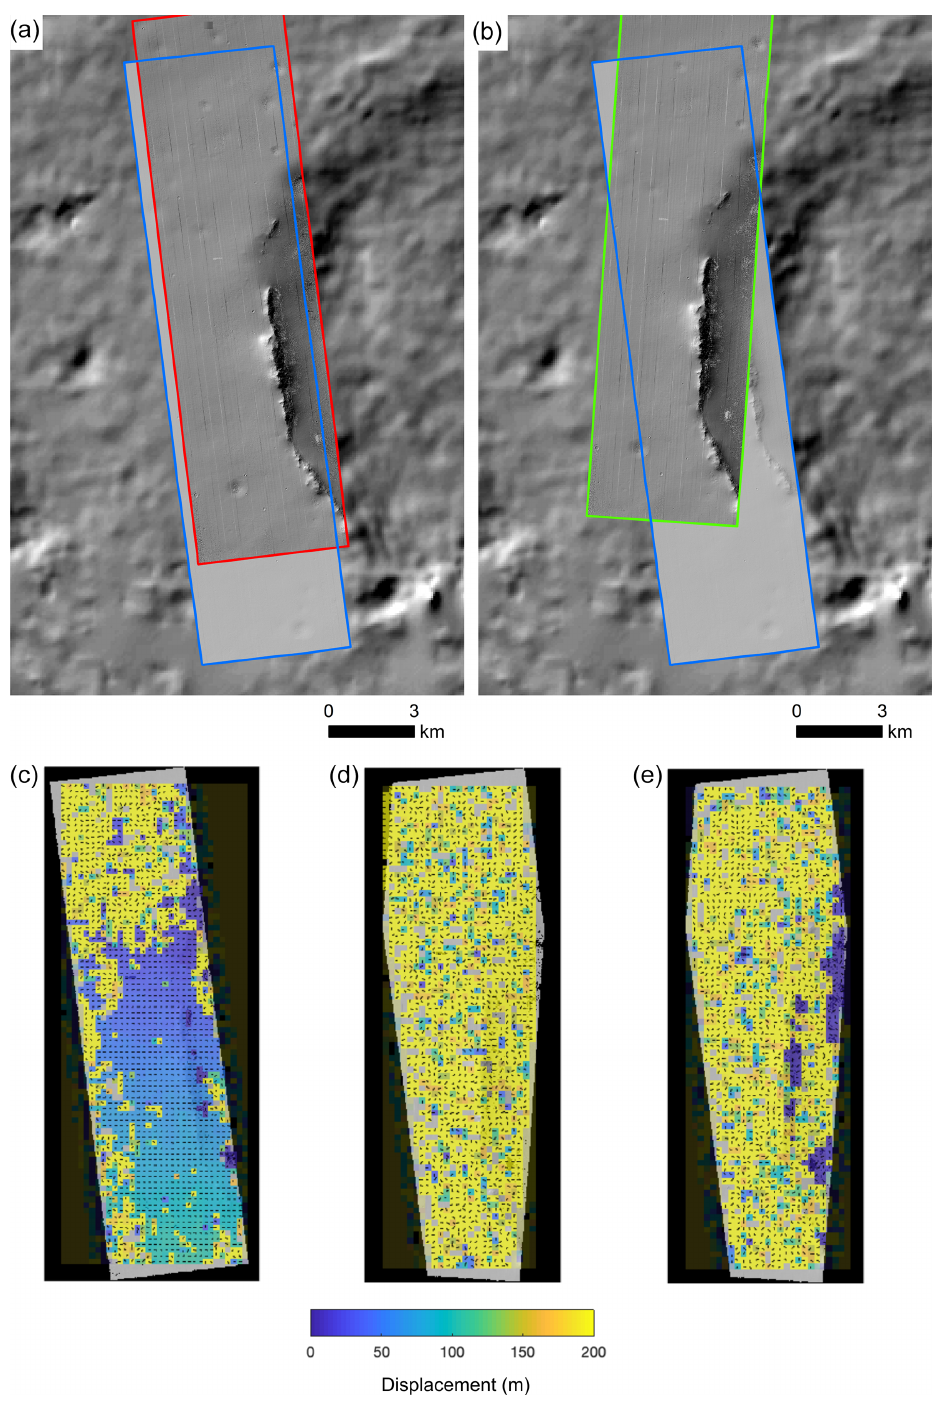
Figure A2. Site 3 DEM alignment between AU DEM 3, the PDS DEM (DTEEC_018701_1775_018846_1775_U01: https://bit.ly/2TrxFXX, last access: 9 February 2019), and the HRSC DEM (h3198_0001). (a–b) Hillshaded PDS DEM (blue box), the AU DEM 3 pre-pc_align (red box), and AU DEM 3 post-pc_align (green box). Background is the hillshaded HRSC DEM. Note the longitudinal artefacts associated with HiRISE bands. (c) Displacement between the AU ( pre-pc_align ) DEM and the PDS DEM. Low displacement around the crater rim indicates strong agreement. Elsewhere, the low-texture terrain hampers pixel matching. (d) Displacement measured between the two AU DEMs. Overlap is limited to flat-featureless terrain, making pixel matching between the two DEMs difficult. (e) Displacement between the ASP ( post-pc_align ) DEM and the PDS DEM. As with (d) , low-texture terrain limits the efficacy of displacement tracking. Panels (c–e) created using the ImGRAFT feature tracking algorithm (Messerli and Grinsted,